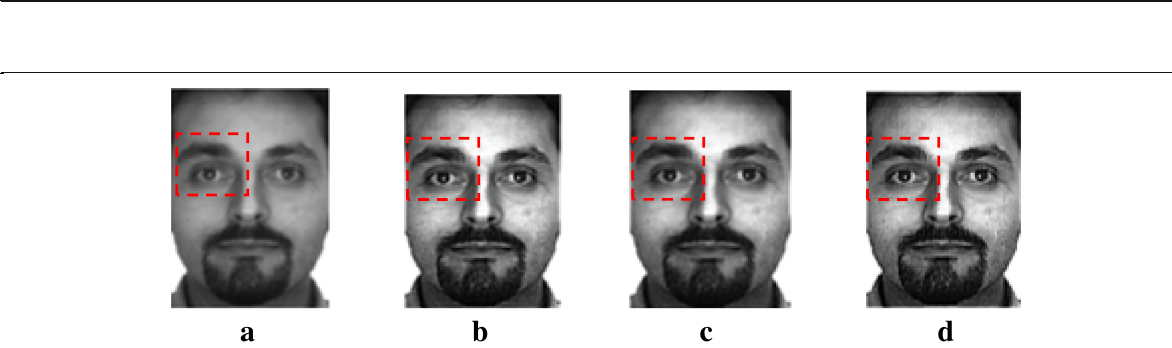
Fig. 6 Qualitative comparison of the different evaluation function with the CSO algorithm on Image 1. a Original. b Munteanu + CSO. c Ye + CSO. d Proposed + CSO